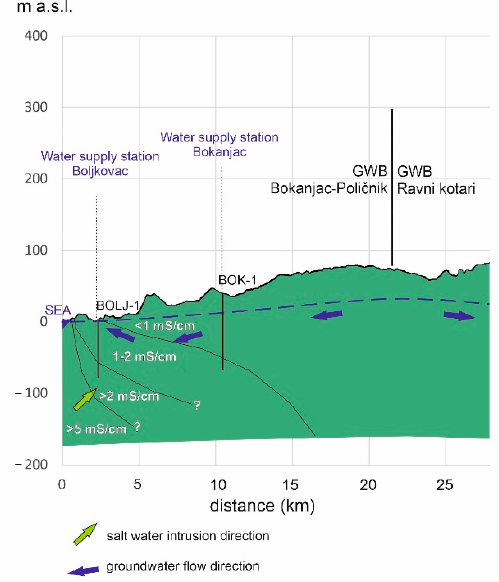
Figure 8. Conceptual model.